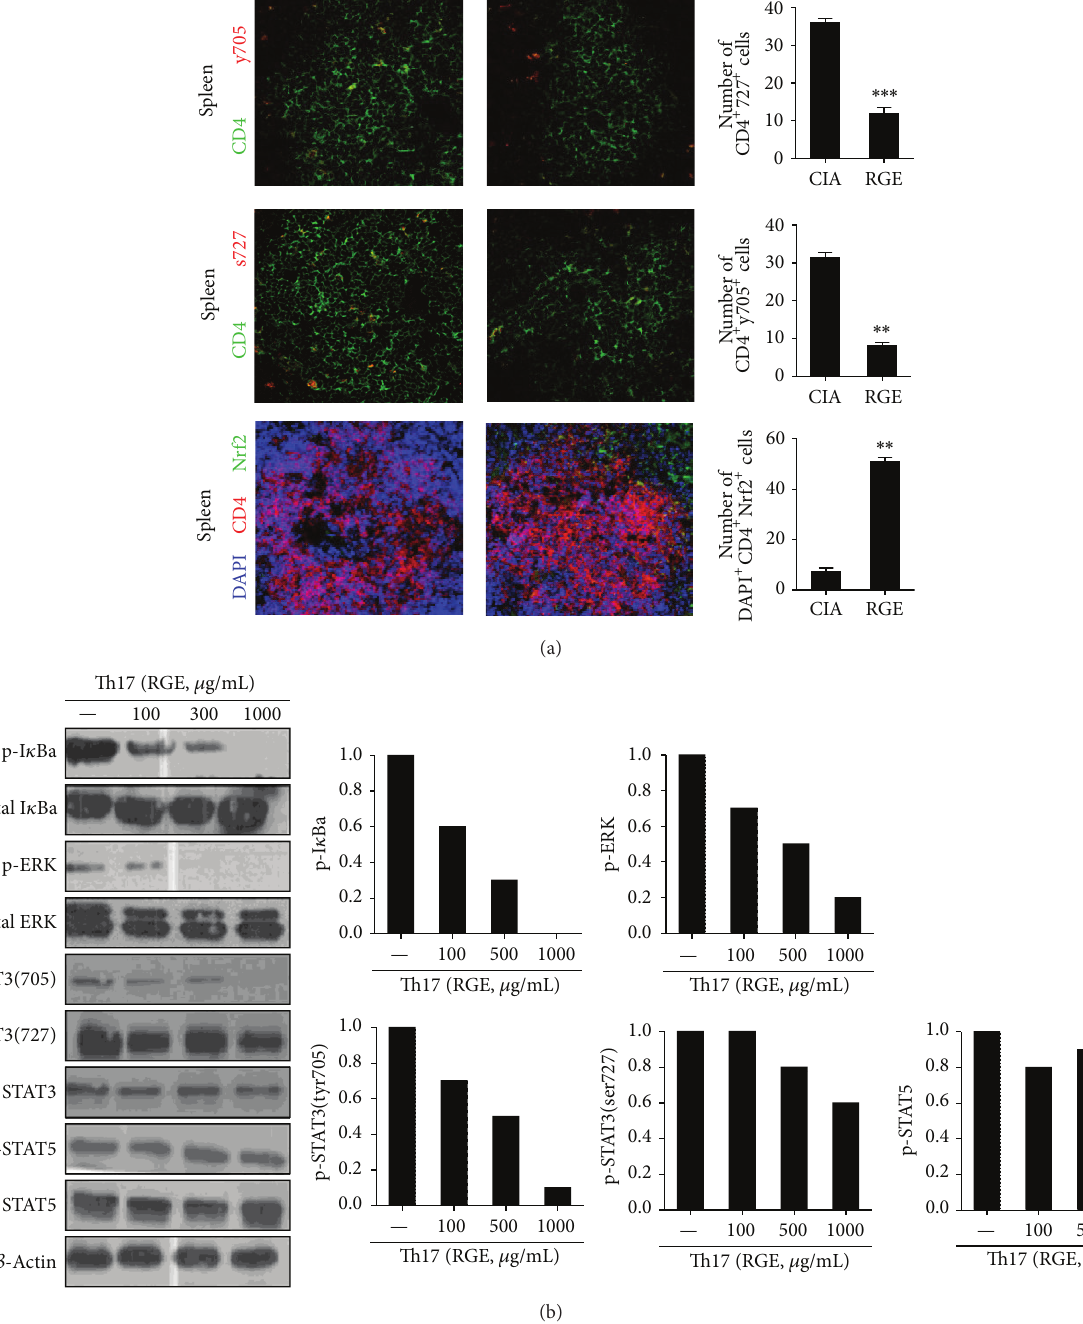
Figure 3: Red ginseng extract reduces STAT3 phosphorylation in the CD4 + T cells in mice. (a) Spleens of red ginseng extract or vehicle- treated CIA mice were subjected to immunostaining for CD4 + pSTAT3y705 + or CD4 + pSTAT3s727 + cells. The number of cells was counted in four independent quadrants. (b) Isolated CD4 + T cells were cultured in a Th17-polarizing condition for 3 days in the absence or presence of various concentrations of red ginseng extract (RGE). The expression of various signaling molecules was determined by western blotting. Data are presented as the mean ± SD of three independent experiments ∗ 𝑃 < 0.05 , ∗∗ 𝑃 < 0.01 , and ∗∗∗ 𝑃 < 0.001 compared to control